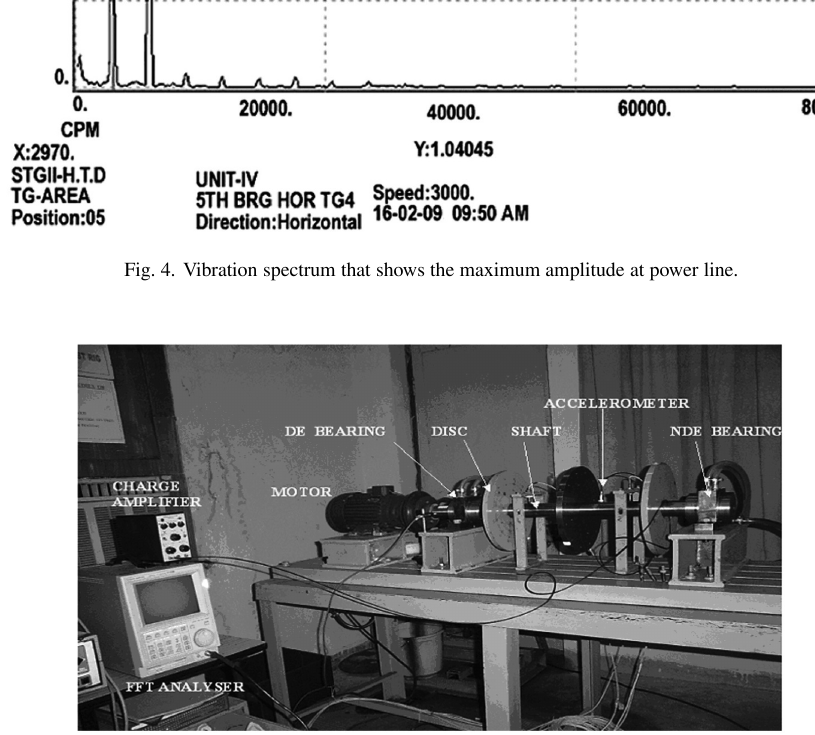
Fig. 5. Instrumentation setup for vibration measurement on test